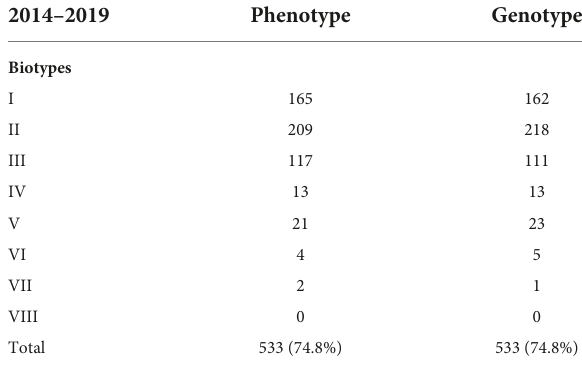
TABLE 2 A total of eight hundred seventy-five invasive cases of Haemophilus influenzae were reported in Denmark from 2014 to 2021.